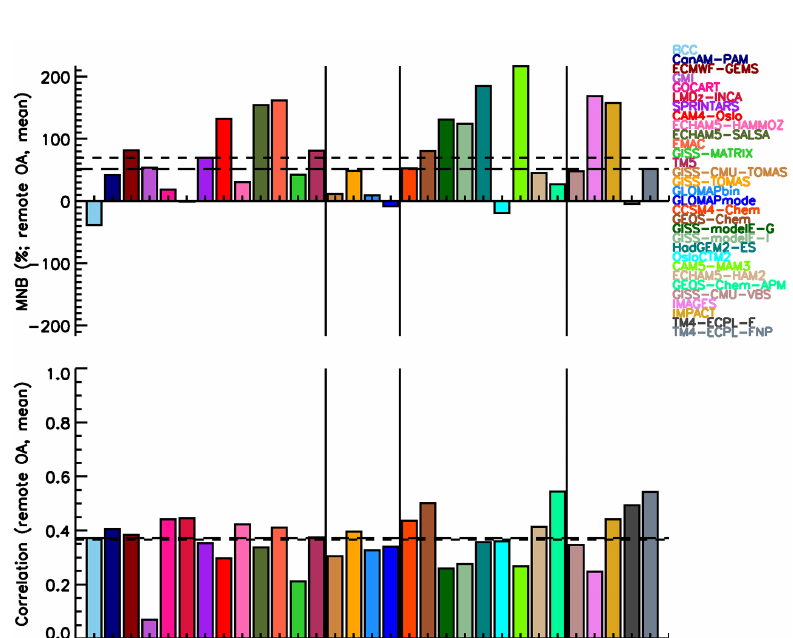
Figure 13. Same as Fig. 10, for remote OA